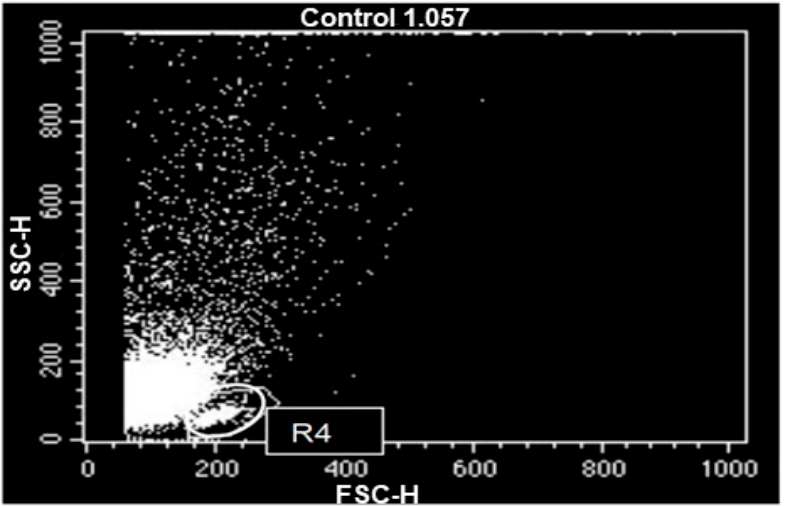
Figure 4. Flow cytometry data, in dot plot, of the peripheral blood mononuclear leukocytes of the studied horses, after a 72-h culture. Cell populations identified according to their forward scatter (FSC) versus side scatter (SSC) profiles, cell size versus granularity and complexity. R4—lymphocyte gate.